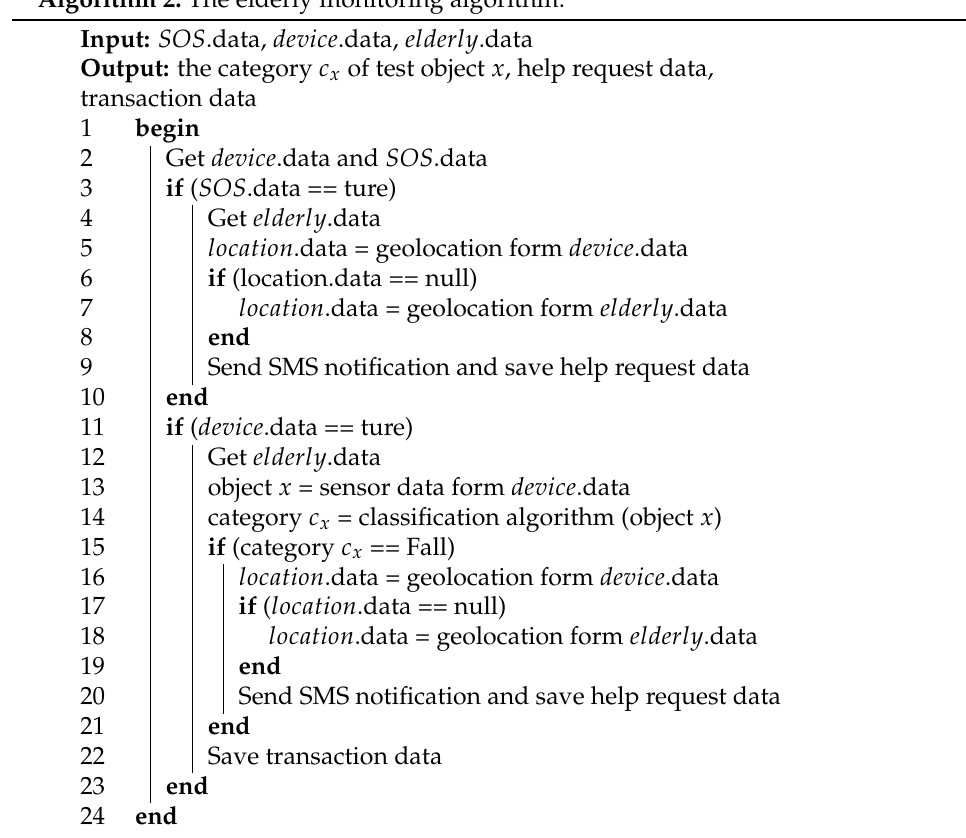
Algorithm 2: The elderly monitoring